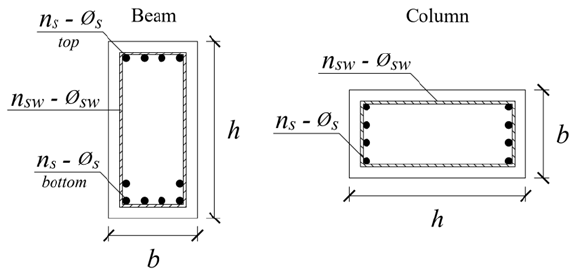
Figure 1. Typical section of a beam and a